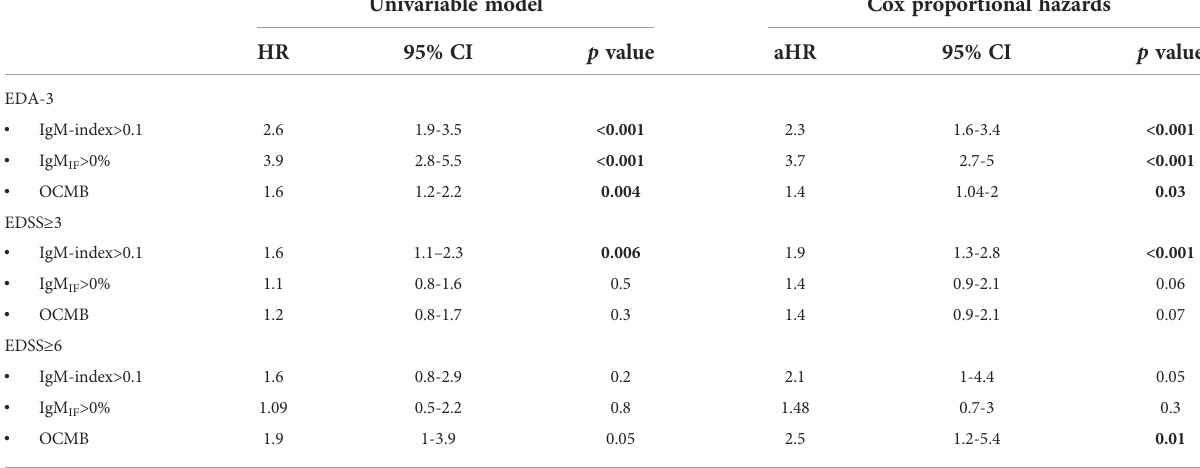
TABLE 2 Unadjusted and multivariable cox regression models for IgM metrics and prediction of 24-month EDA-3 status, EDSS ≥ 3, and EDSS ≥